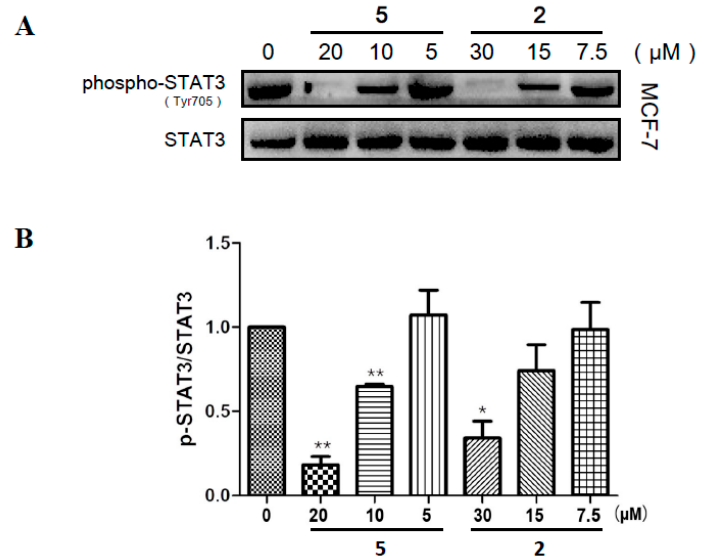
Figure 6. Inhibitory effects of compounds 2 and 5 on the phosphorylation of STAT3 on Tyr705 in MCF-7 cells. The cells were incubated with compound 2 or 5 for 6 h with the indicated concentrations. ( A ) The protein levels of pSTAT3 Tyr705 and total STAT3 were detected by western blotting. ( B ) Fold changes of western blotting ( n = 3). Data represent mean ± SD. * p < 0.05, ** p < 0.01 compared with the control group.